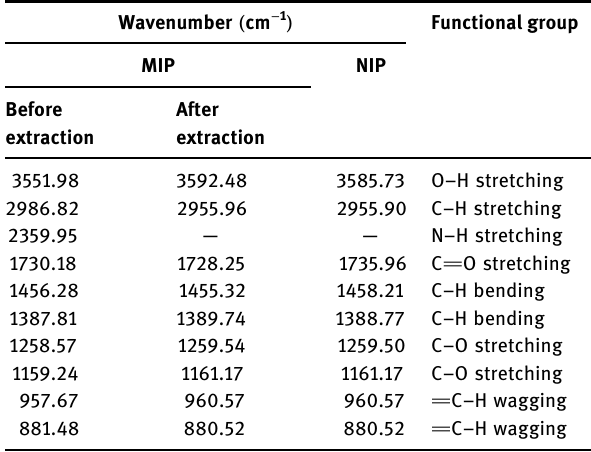
Table 2: The FTIR result of MIP and NIP by precipitation polymer